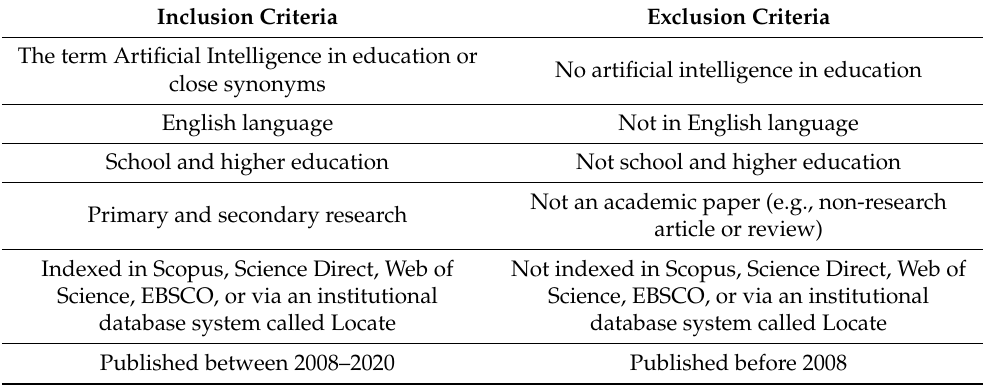
Table 2. Final inclusion and exclusion criteria.